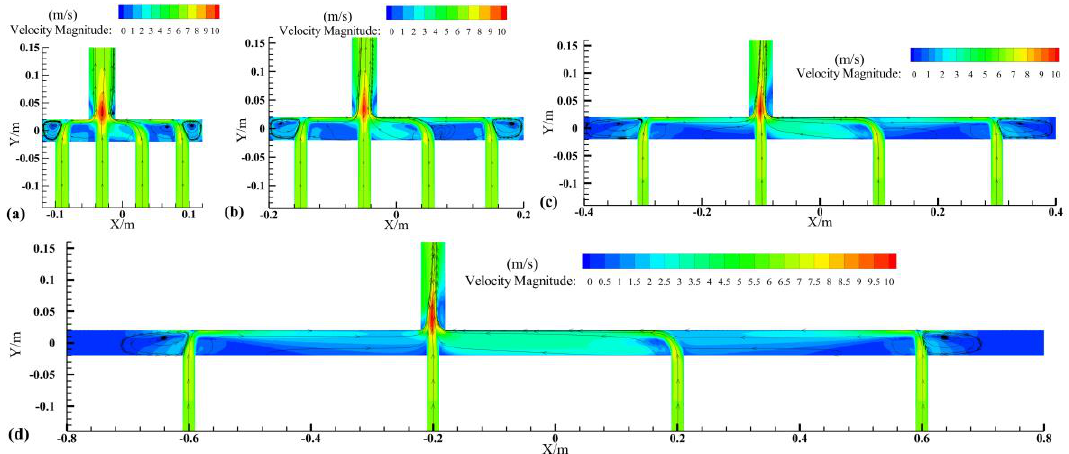
Figure 14. Velocity magnitude contours for configuration “C” cases: ( a ) L = 3d; ( b ) L = 5d; ( c ) L = 10d; ( d ) L = 20d.